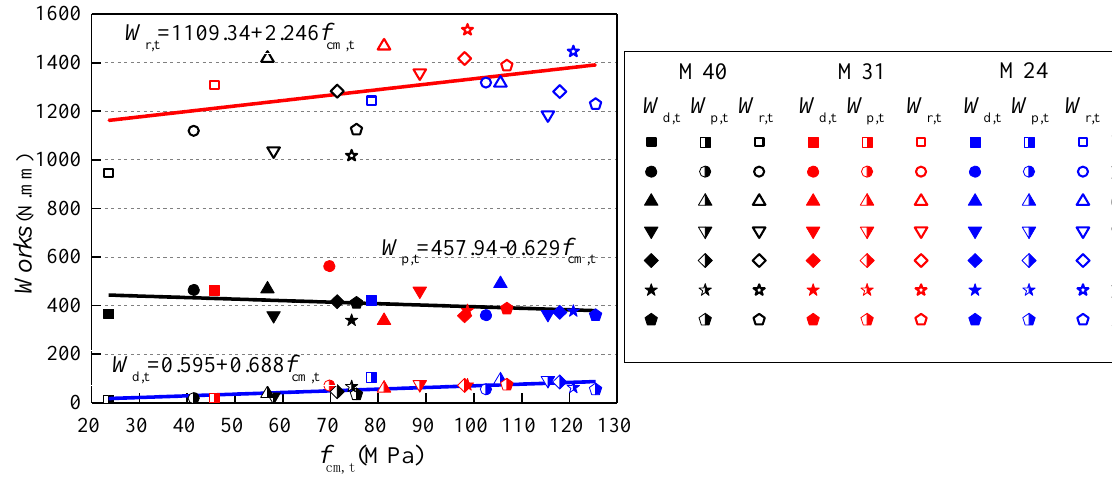
Figure 11. Relationship of bond work and compressive strength of mortar. The curing age has little influence on the R pr,t . The R pr,t of M40, M31 and M24 kept constant of 64.3%, 71.2% and 69.5% with variation coefficient of 0.05, 0.07 and 0.06 from 7 to 360 days, successively. The R pr,t of M31 was higher than those of M40 and M24 at the same curing age. This indicates the energy dissipation capacity of steel fiber at the bearing capacity of SFRC plays an important role in the whole pull-out process. The relationship of energy ratios and the compressive strength of mortar are presented in Figure 12. The R d,t and the R pr,t increased with the mortar compressive strength. The R dp,t decreased with the increase in mortar compressive strength, which reflects the increase in bond brittleness with the mortar strength. This phenomenon needs to be paid attention in the normal serviceability of SFRC structures.